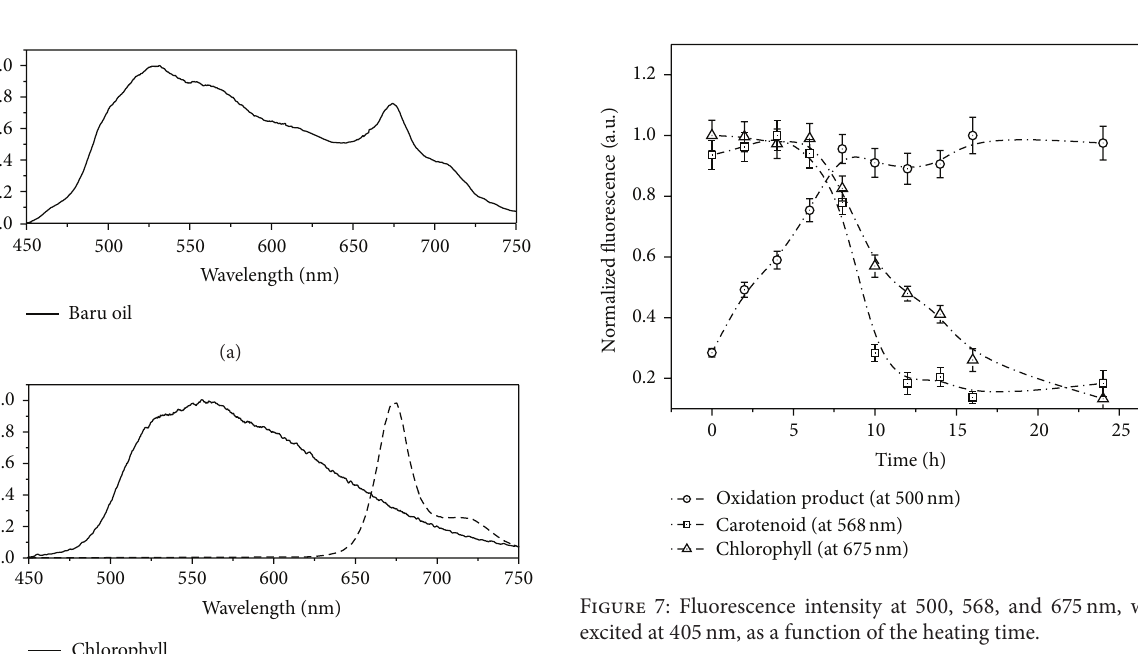
Figure 5: (a) Decrease in absorption over the degradation period. (b) Absorbance at 475 nm as a function of the heating time.